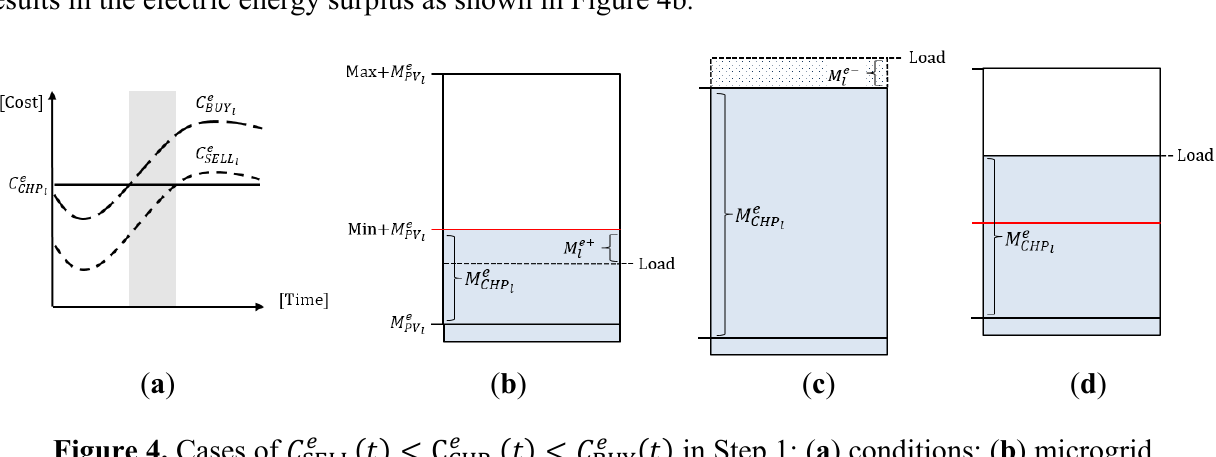
(cid:2887)(cid:2892)(cid:2900) (cid:3287)